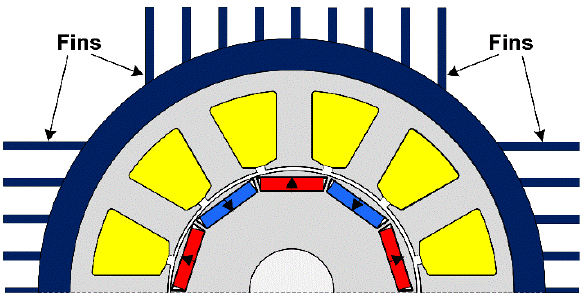
Figure 6. Configuration of finned frame for an IPM machine.